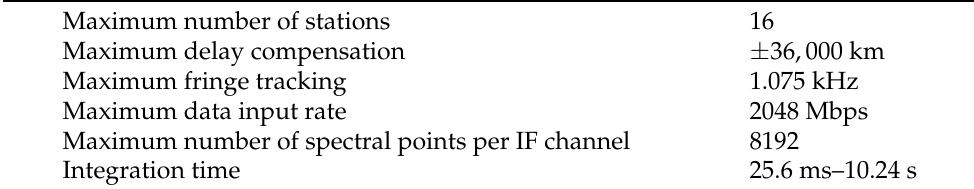
Table 4. Basic specifications of the Daejeon